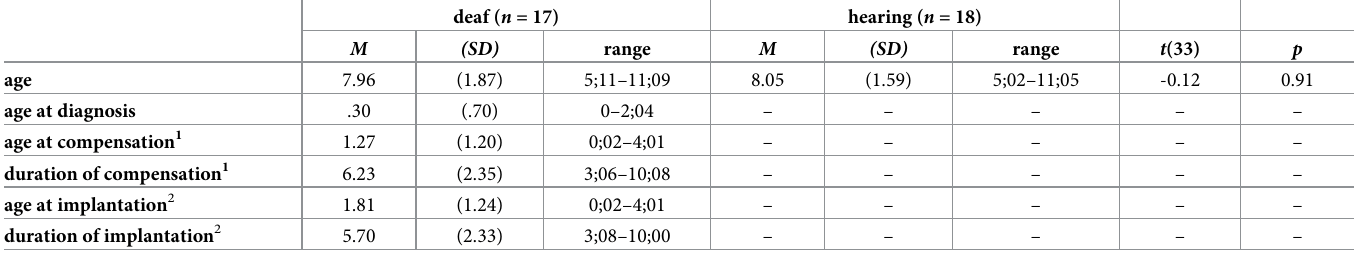
Table 2. Participants’